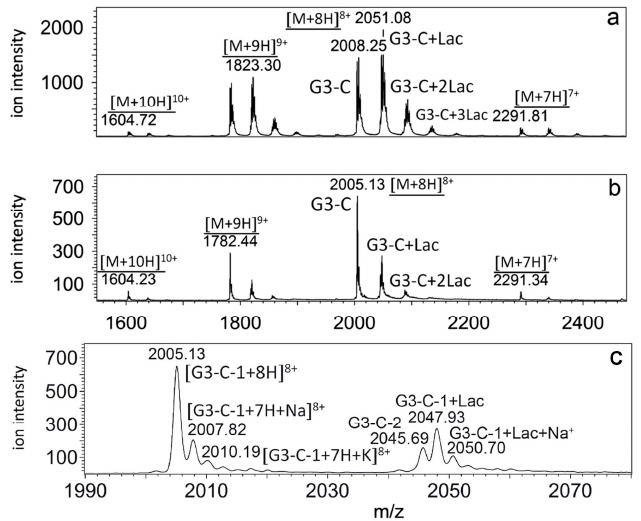
Figure 5. nanoESI Q-TOF (quadrupole-time-of-flight) spectra of the galectin-3C sample under native